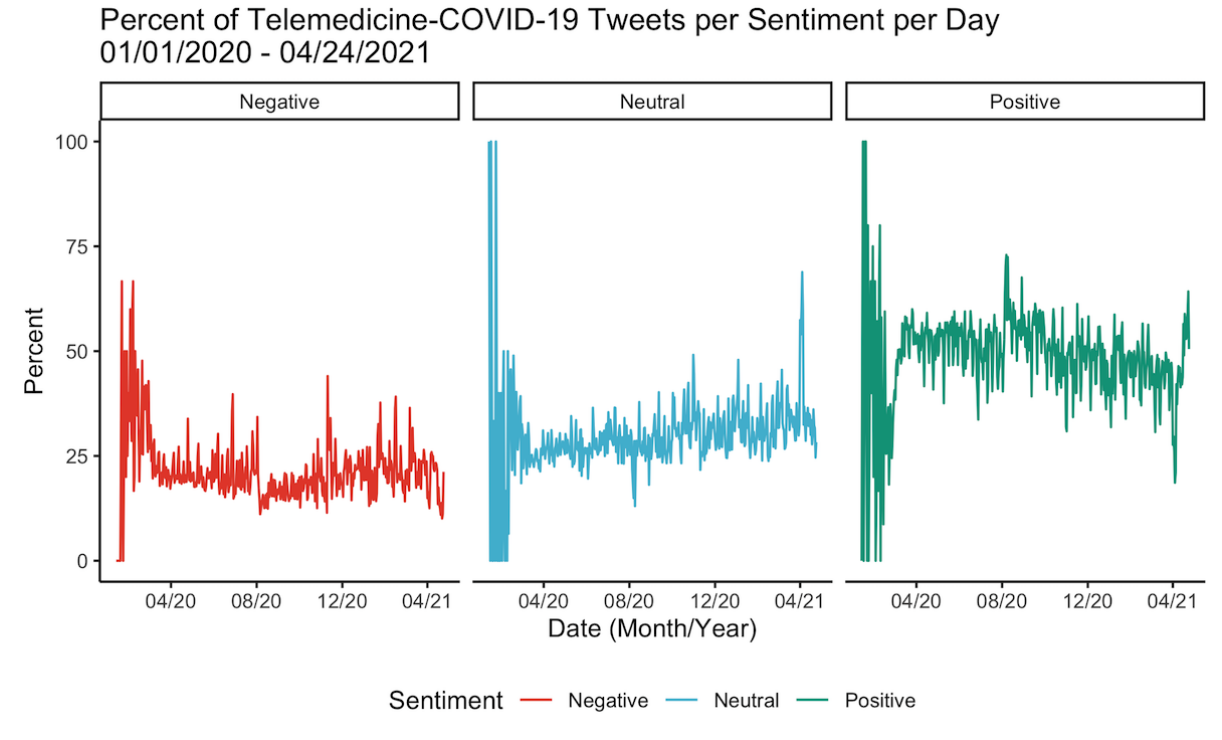
Figure 3. Changes in the frequency of positive, negative, and neutral tweets mentioning telemedicine and COVID-19 posted between January 1, 2020, and April 24, 2021 (N=351,718).